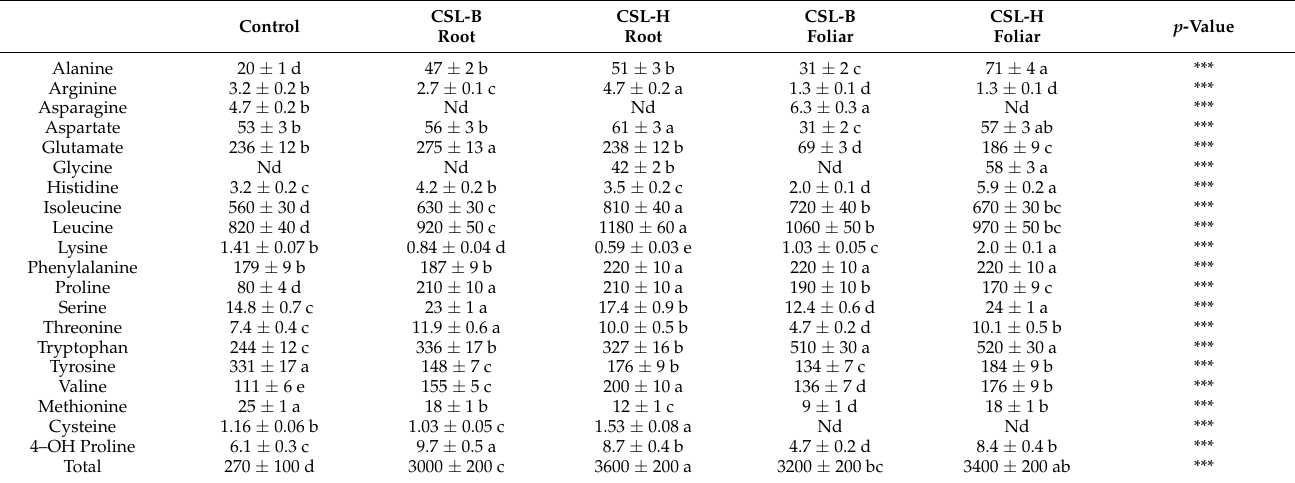
Table 6. Aminogram of each of the treatments tested in this experiment. The data are from the last sampling, 7 days after the last application of the treatments. Control CSL-B CSL-H CSL-B CSL-H p -value